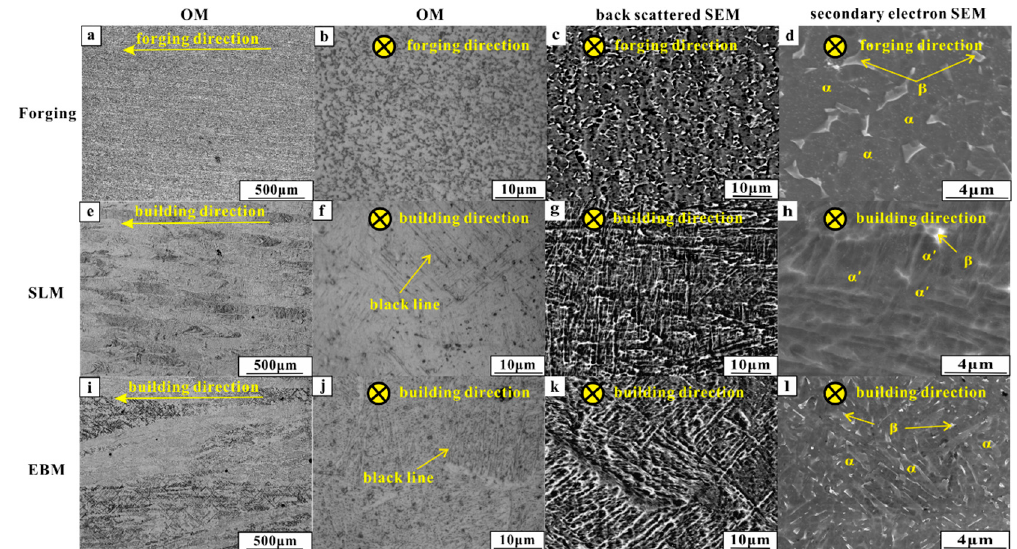
Figure 3. OM, back scattered SEM and secondary electron SEM images of samples produced by ( a – d )